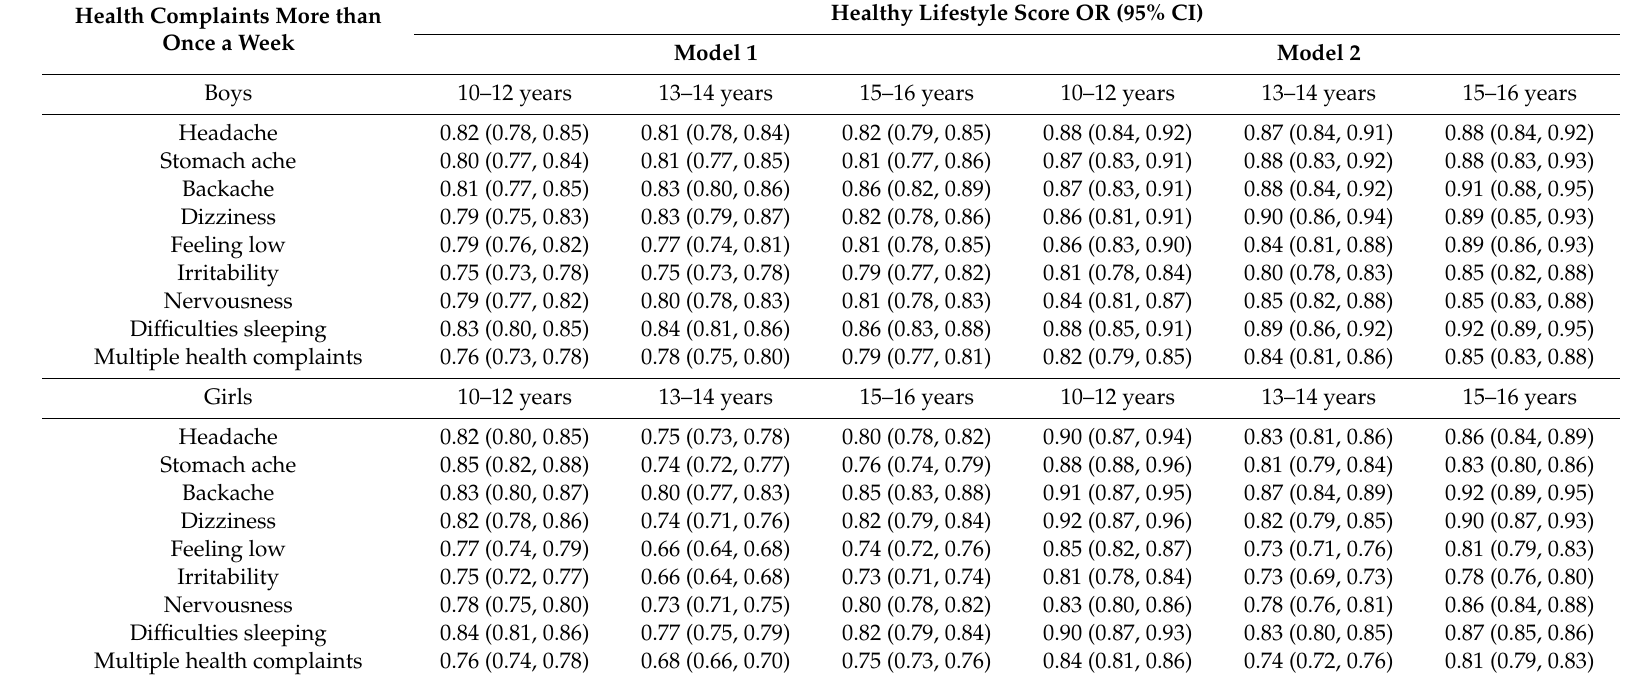
Table 3. Association between healthy lifestyle score and adolescents’ health